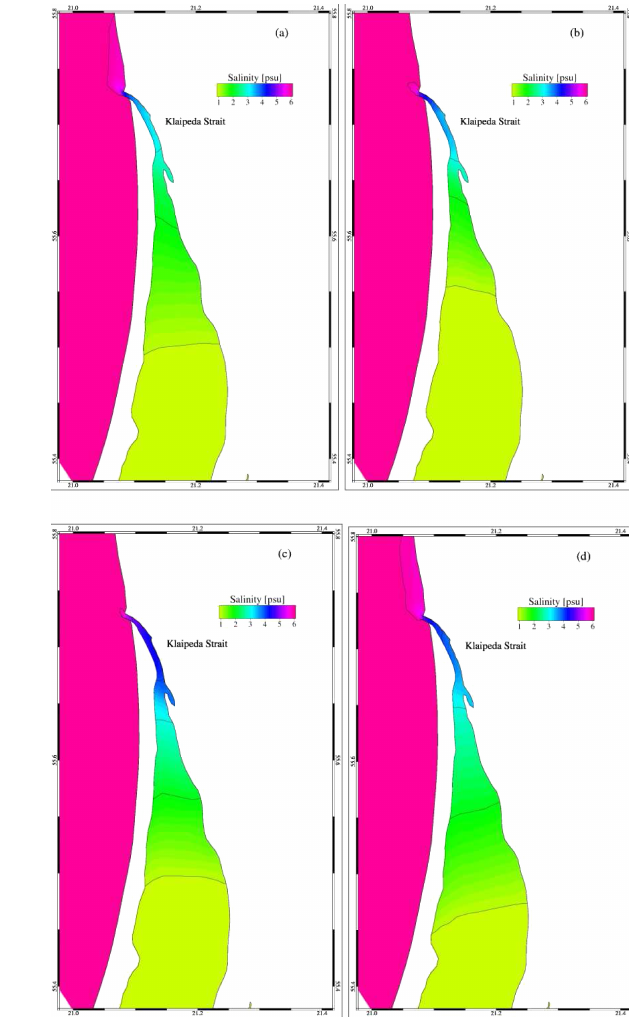
Figure 5. Seasonal maps of residual currents averaged over the years 2004–2014. Maps show winter (a) , spring (b) , summer (c) , and autumn (d) .